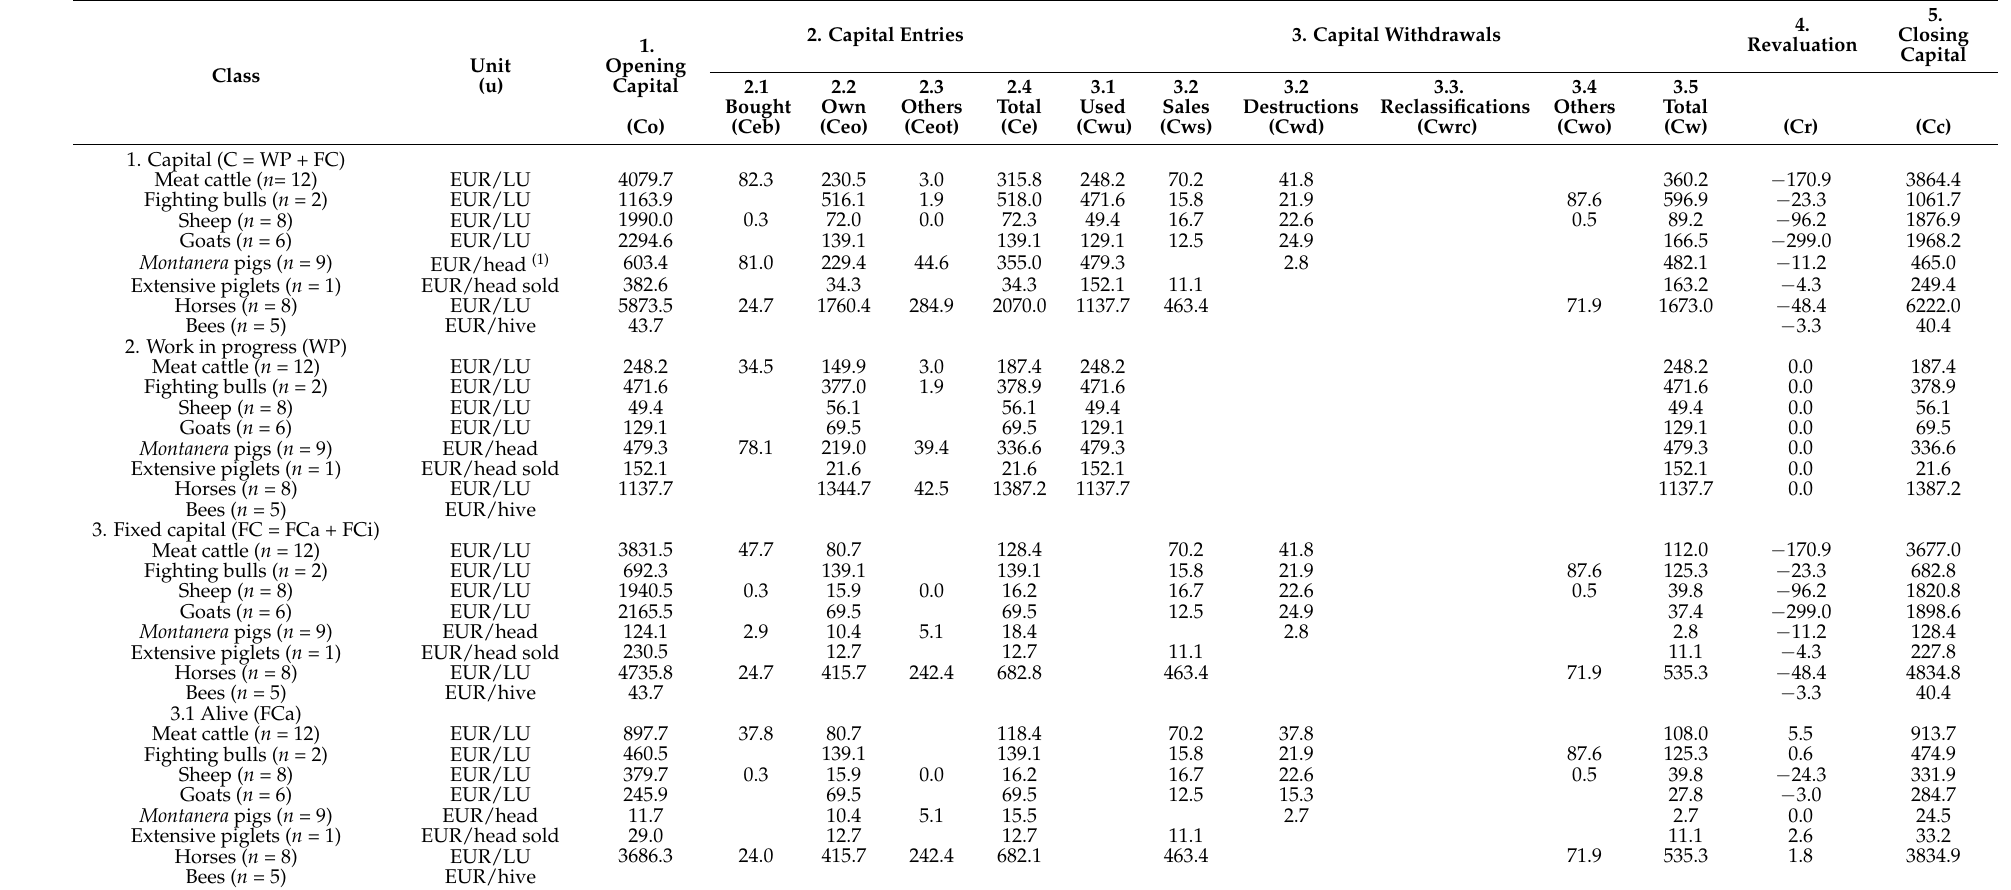
Table A4. Livestock species capital balance under the AAS of large privately owned dehesas in Andalusia (2010: